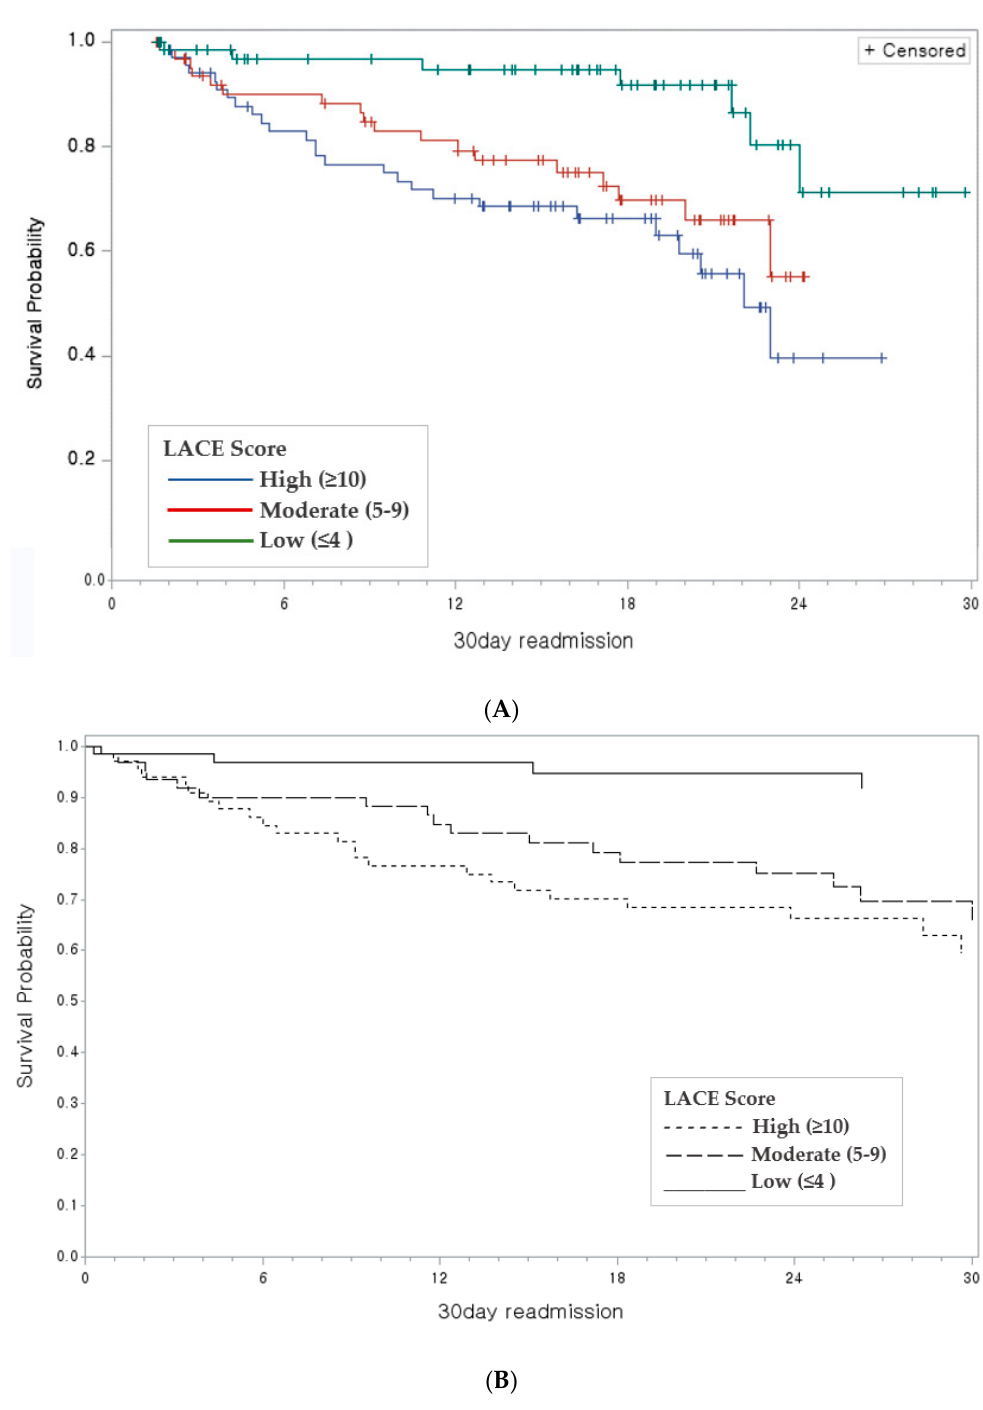
Figure 3. Kaplan–Meier survival plot : ( A ). Product limit estimates of survival of for patients with AMI and colors indicates the LACE scores ; ( B ) Overall survival of AMI patients with 30-day readmission and LACE index scores <4 (black line), 5–9 (dashed blue line) and ≥ 10 (solid dashed line).